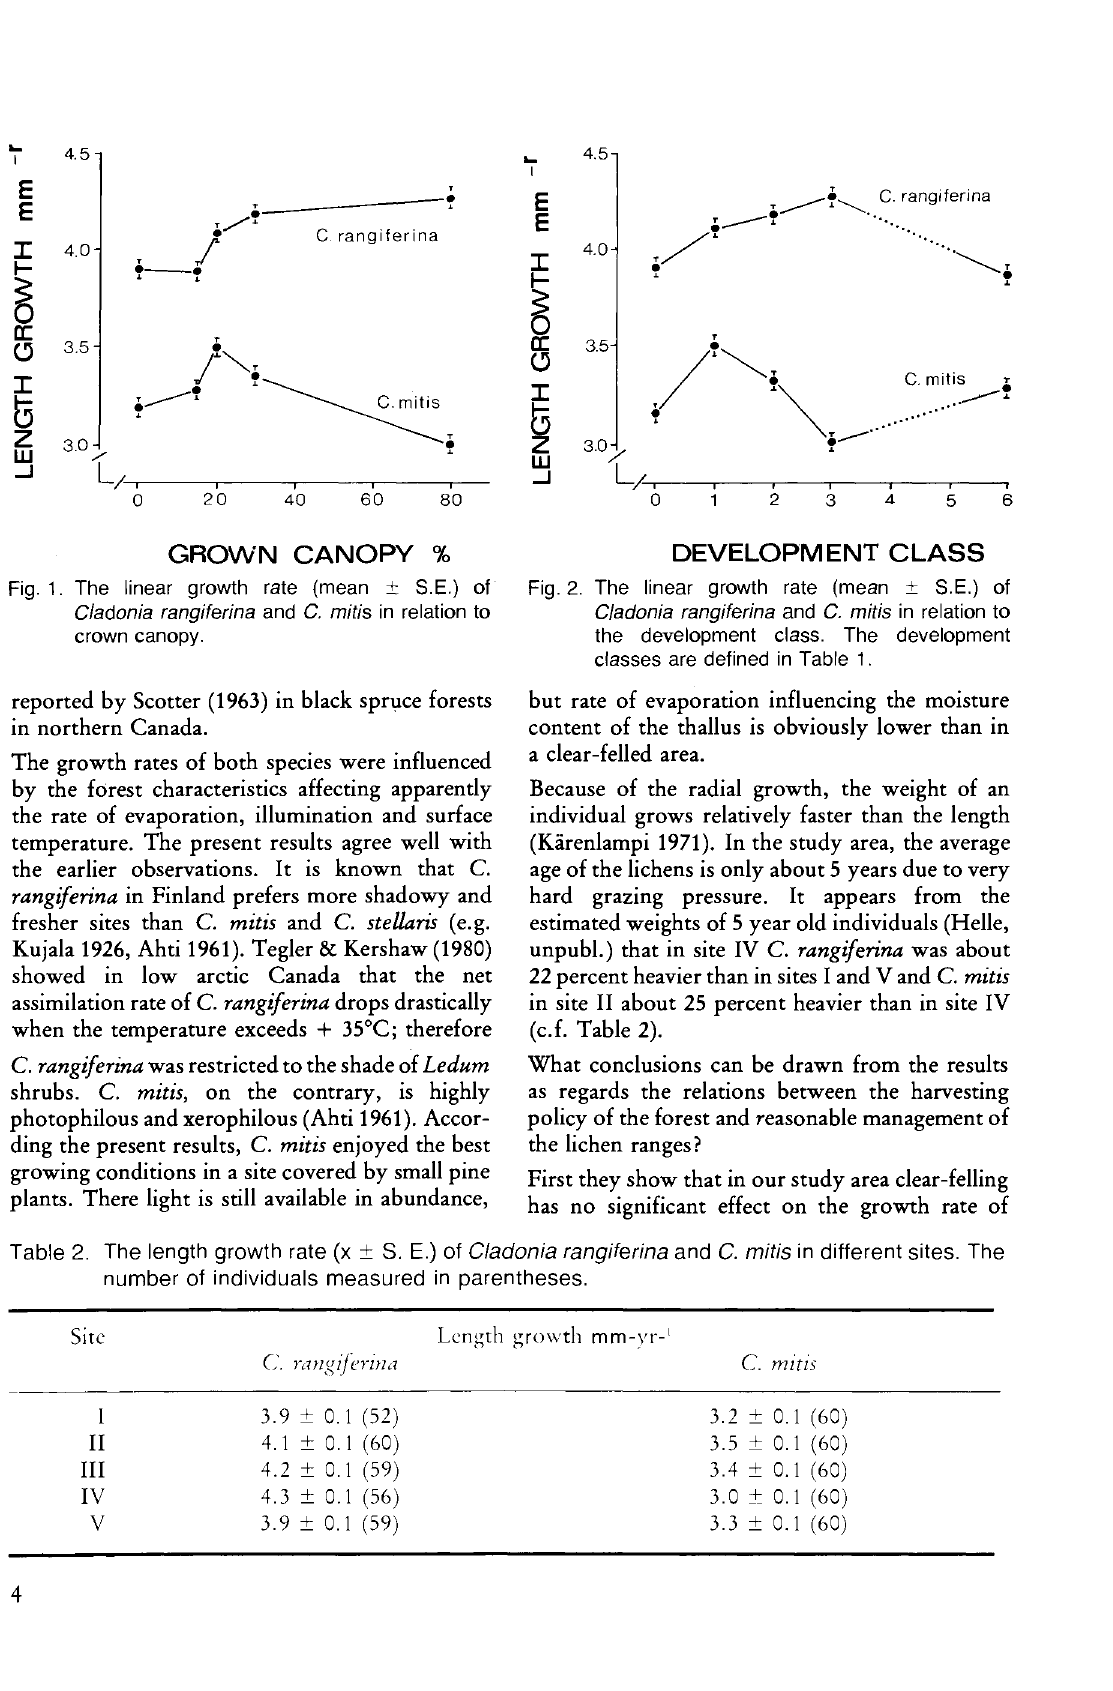
Fig. 1. The linear growth rate (mean ± S.E.) of Cladonia rangiferina and C. mitis in relation to crown canopy.